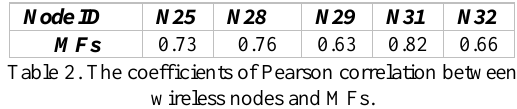
Table 2. The coefficients of Pearson correlation between